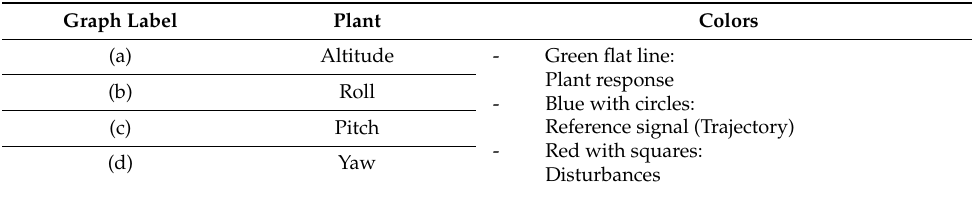
Table 2. Details of Fuzzy-PD simulation results (Figures